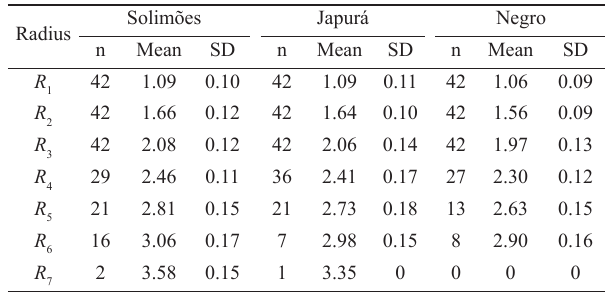
Tab. 2. Summary of descriptive statistics of average radius